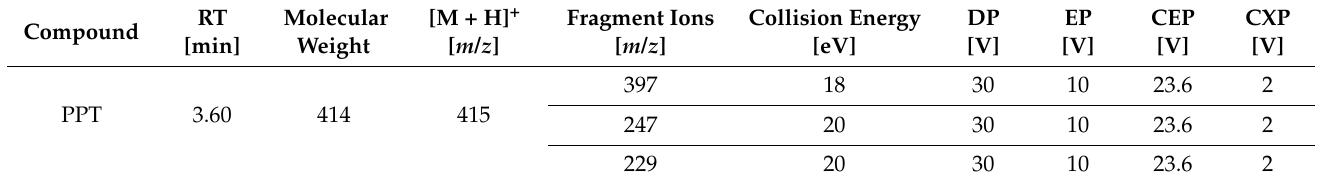
(Table 2). Quantification was based on the corresponding peak area. The limits of detection (LOD) and quantification (LOQ) for PPT (Table 3) were determined at a signal-to-noise ratio of 3:1 and 10:1, respectively, by injecting a series of dilute solutions with known concentrations. Table 2. LC-ESI-MS/MS parameters for identification of podophyllotoxin